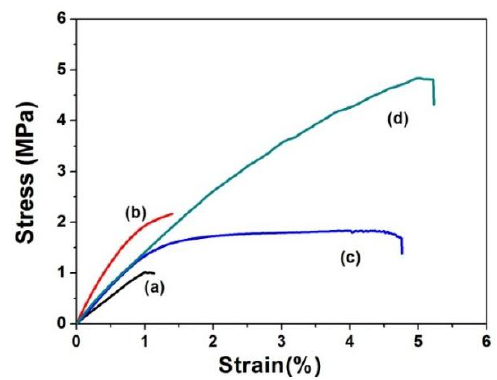
Figure 9. Stress-strain curves of SF fibers mats and SF-SELP core-shell fibers mats before and after methanol treatment: ( a ) SF fibers mats; ( b ) SF fibers mats after methanol treatment; ( c )